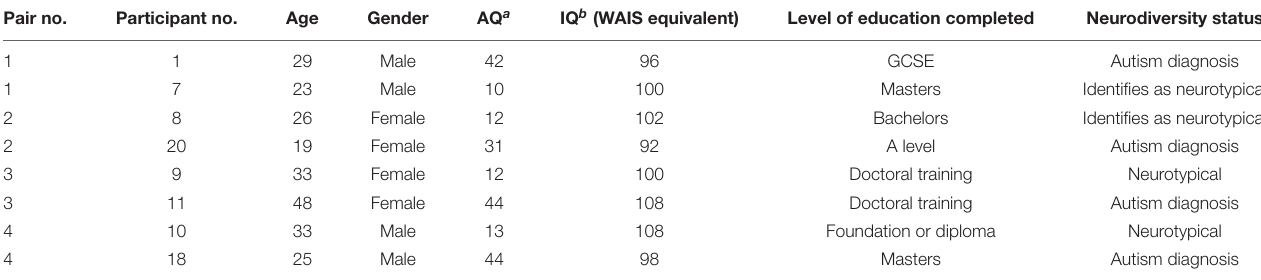
TABLE 2 | Participant demographics. Pair